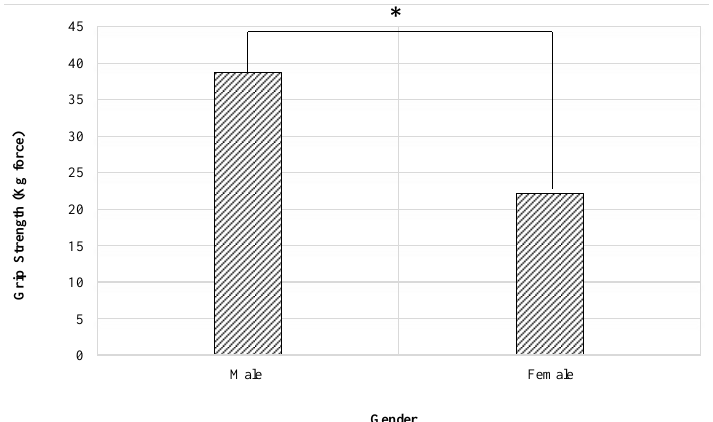
Figure 3. Effect of gender on the grip strength (* means there is a significant difference between levels) .